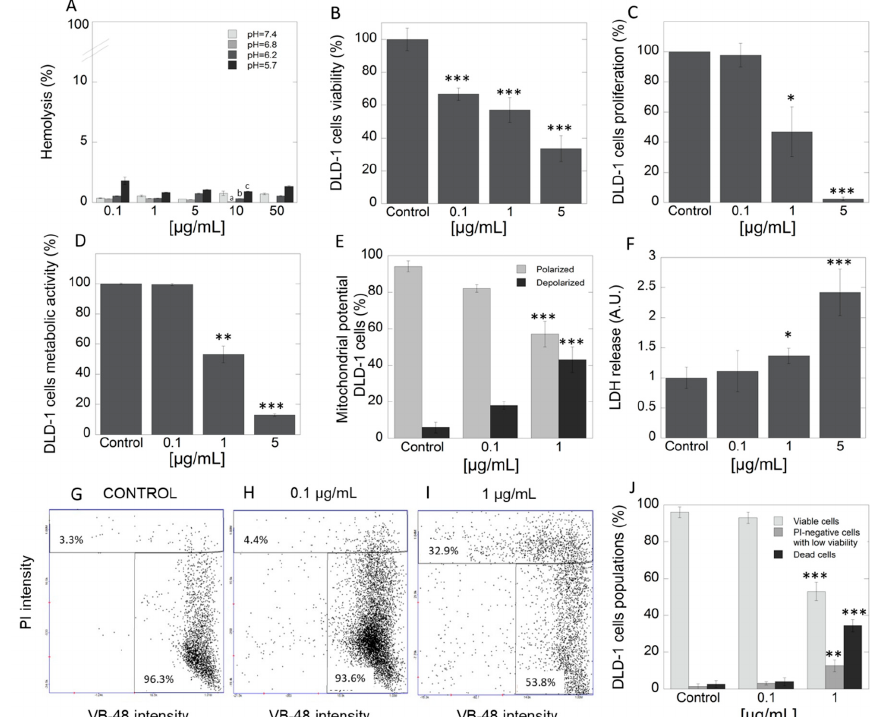
Figure 2. Hemocompatibility and cytotoxicity of Heterobasidion annosum (HA) extract against DLD-1 cells. Panel A shows high compatibility of HA extract against representative of host cells–RBC cells. The ability to decrease viability (panel B ) and proliferation (panel C ) of DLD-1 colorectal cancer cells after treatment with HA extract at di ff erent concentration range 0.1–5 µ g / mL. Pleiotropic mode of action of HA extract—reduction of metabolic activity ( D ), increasing number of depolarized cells ( E ), and leakage of LDH from the treated cells ( F ). The distribution of thiol levels in DLD-1 cells after treatment by HA extract- fluorescence intensity scatters ( G -control, H -0.1 µ g / mL and I -1 µ g / mL) and column plot ( J ). PI—propidium iodide, VB-48—VitaBright-48 iodide; Statistical significance: (pH = 7.4) vs. (pH = 6.8) a p < 0.01; (pH = 6.8) vs. (pH = 6.2) b p < 0.01; (pH = 6.8) vs. (pH = 5.4) c p < 0.01 (panel A ); * p < 0.05 vs. control, ** p < 0.01 vs. control; *** p < 0.001 vs.